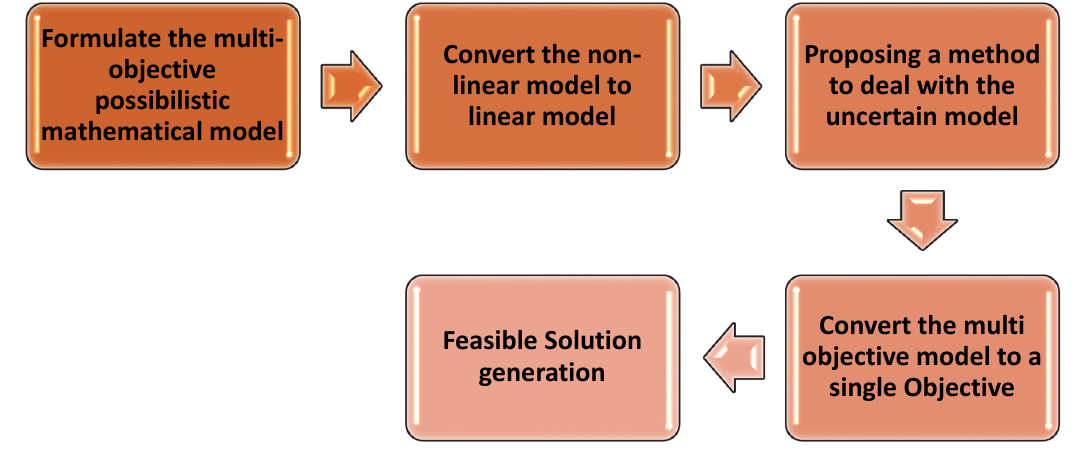
Fig. 2. The steps of the proposed